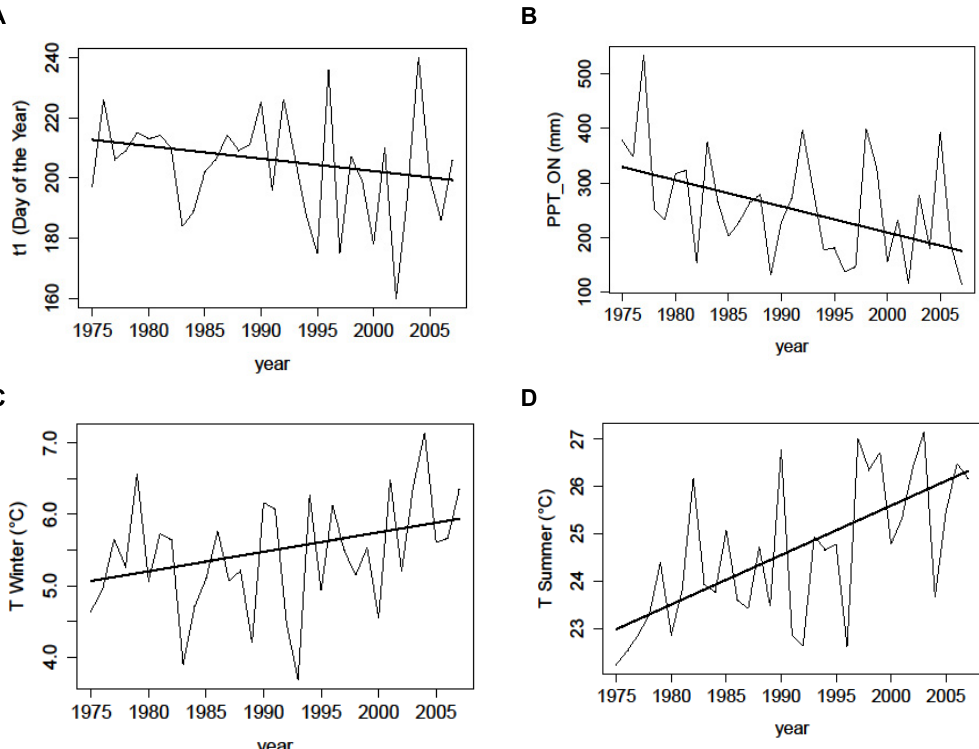
Figure 9. Yearly values (thin black line) over the 1985–2008 period of the climate variables (drought onset t 1 ( A ), precipitation for October November P_ON ( B ), winter temperatures for October ‐ January ( C ), summer temperatures for June July August ( D )) presenting a significant trend. The trend line (thick black line) is also shown. Table 5. Temporal trend in climate variables (temperatures for June, July, and August (T_JJA),